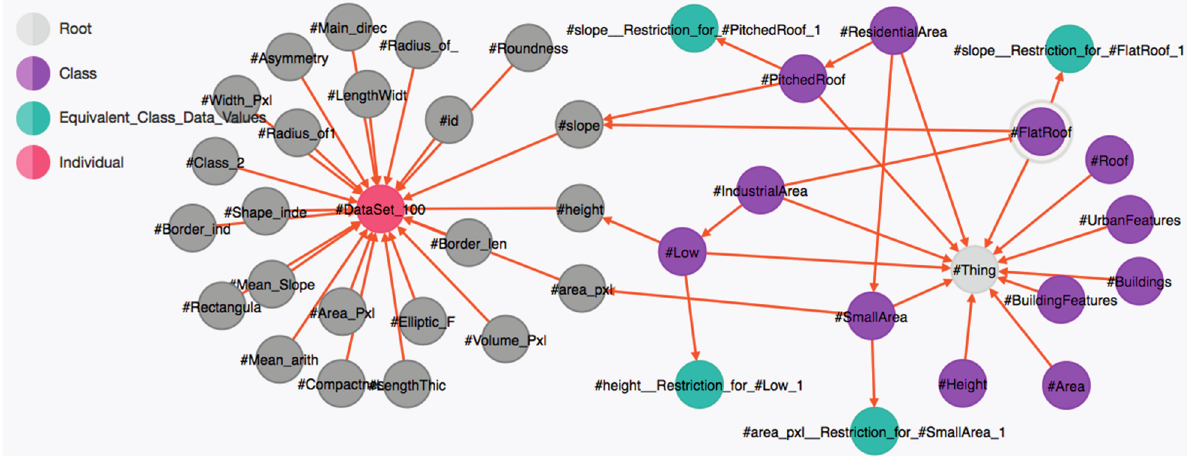
Figure 7. Relationship between individuals and class